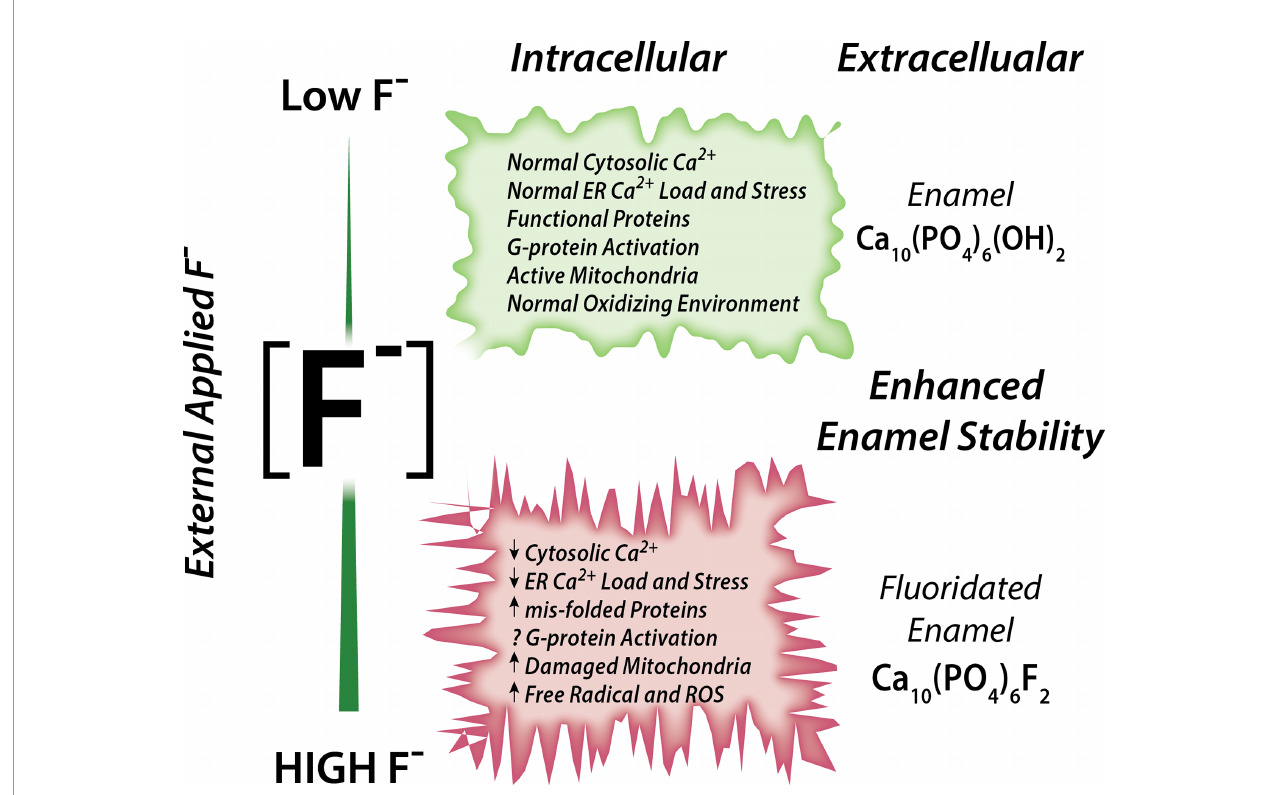
FIGURE 1 | Schematic of the effects of fl uoride in enamel cells. Fluoride modulates Ca 2+ homeostasis with a dual effect. Low concentration leads to normal cytosolic and ER Ca 2+ load, lack of ER stress leading to normal ER and mitochondrial function. High fl uoride induces abnormal cytosolic and ER Ca 2+ , possibly via impairment of G-protein activation, and dysregulates cell metabolism.